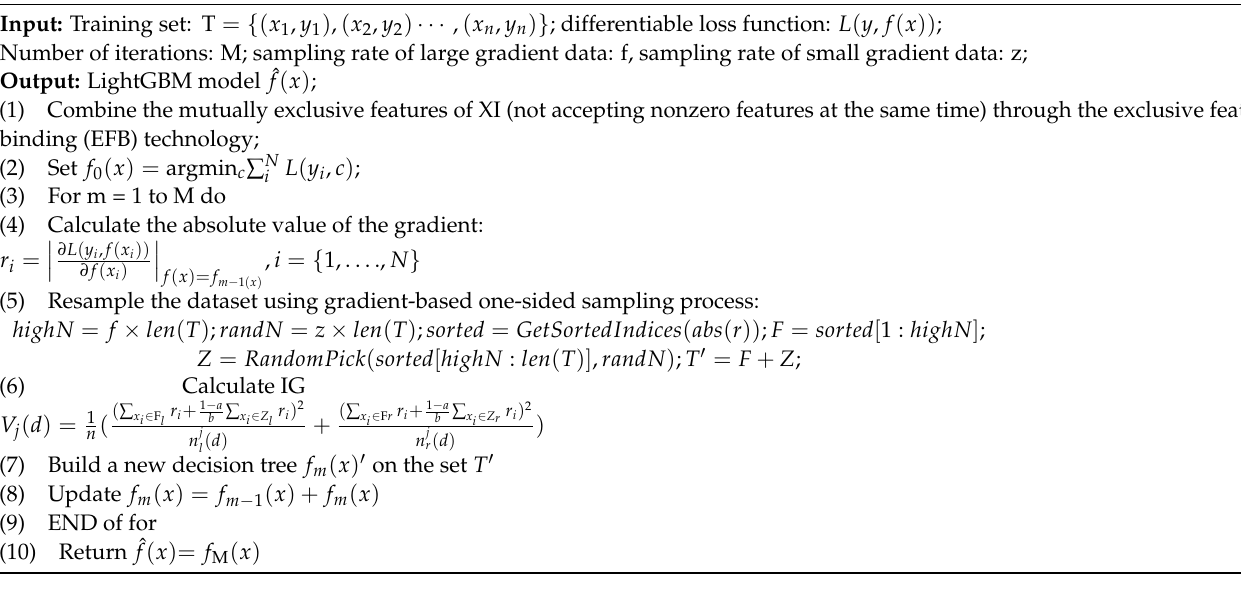
Algorithm 1. The LightGBM